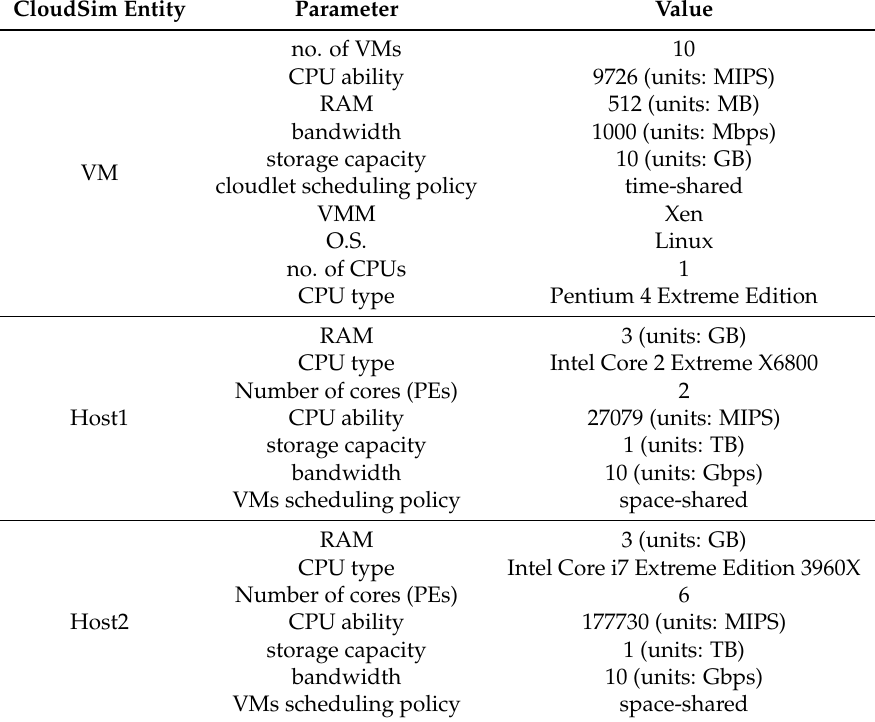
Table 10. CloudSim parameters for simulations with artificial data